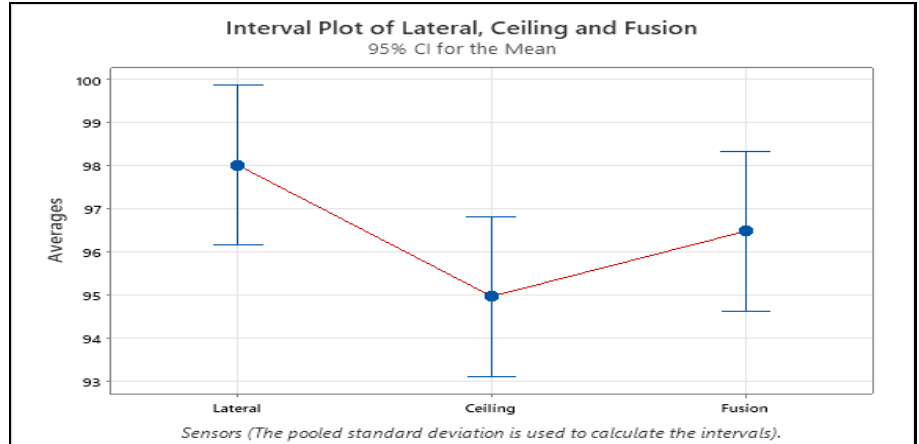
Figure 13. Interval plot of Lateral, Ceiling, and Fused datasets computed from their pooled standard deviation. Nevertheless, although previous analysis indicated a higher Mean average in favour of T1, one-way ANOVA of the